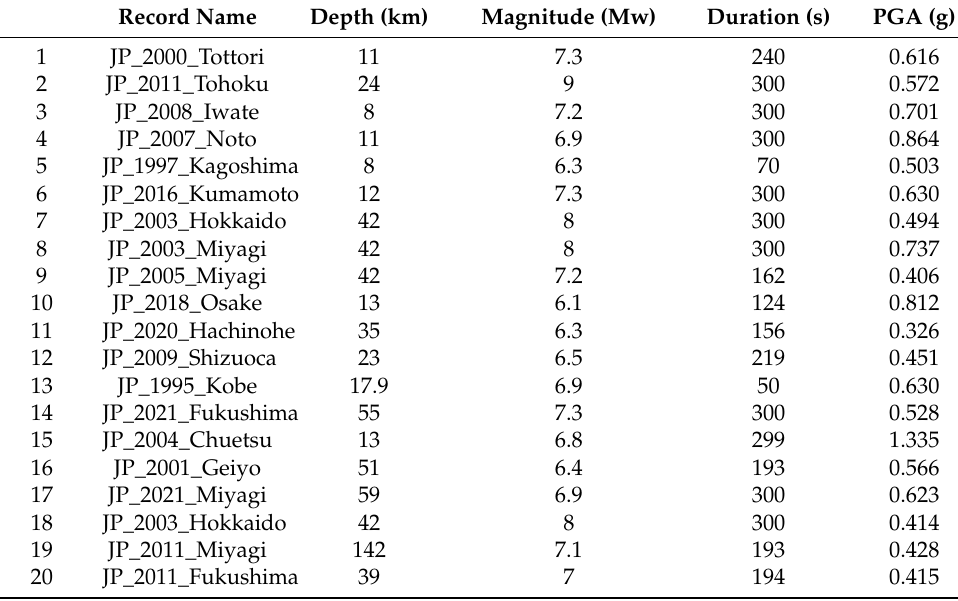
Table 5. Summary of input earthquake ground